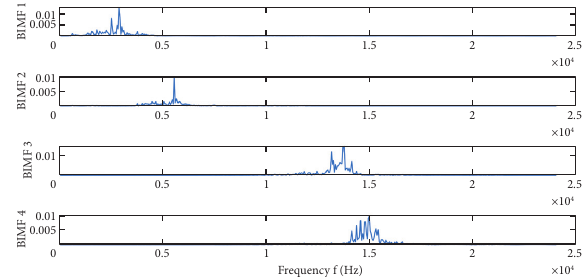
Figure 6: Time domain diagram of BIMF components of outer ring fault vibration signal through VMD.